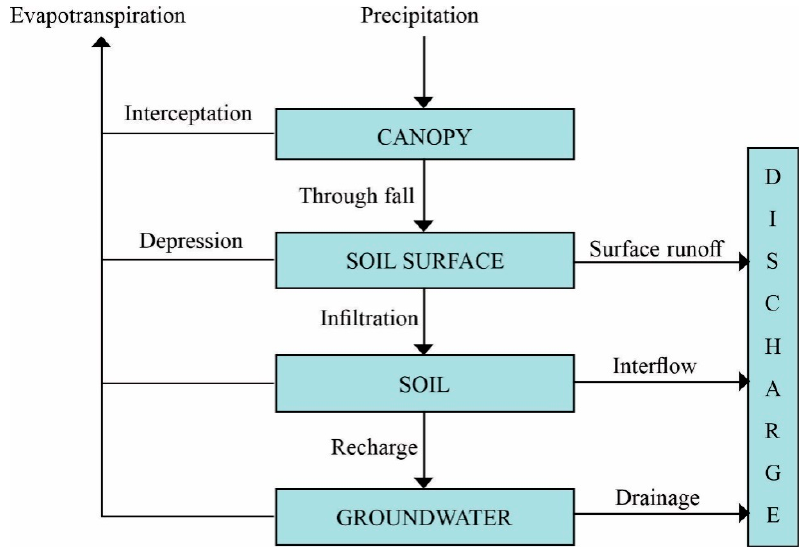
Figure 3. Hydrological processes and WETSPA (Water and Energy Transfer between Soils, Plants, and Atmosphere) model structure